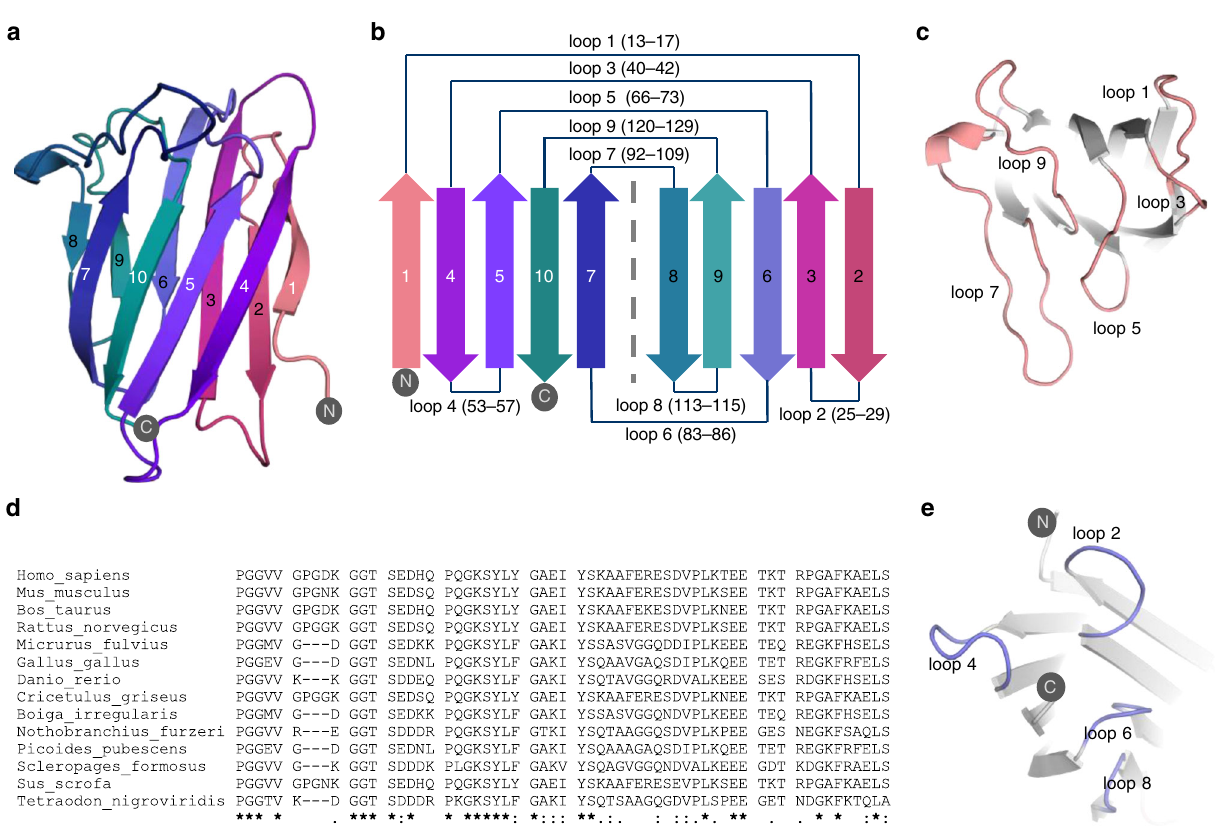
Fig. 1 Crystal structure and sequence conservation of MYDGF. a Cartoon representation of the MYDGF structure with gradual coloring from red (N-terminus) to green (C-terminus). b Topology diagram of MYDGF displays the connectivity between the 10 β -sheets. c The elongated loops on the top face are highlighted in red. d Multiple sequence alignment of the loop 1 – 9 regions distinct MYDGF species (full alignment in Supplementary Fig. 5). High sequence conservation is observed especially in loops 1, 3 and 5. Panel e shows MYDGF's bottom face with the short loops (blue) and both